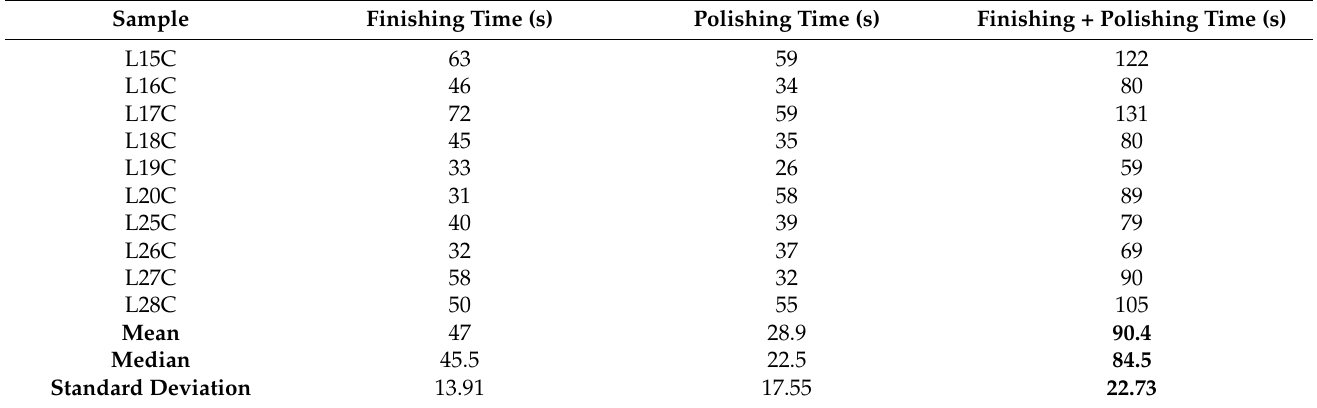
Table 12. Finishing time data in the control